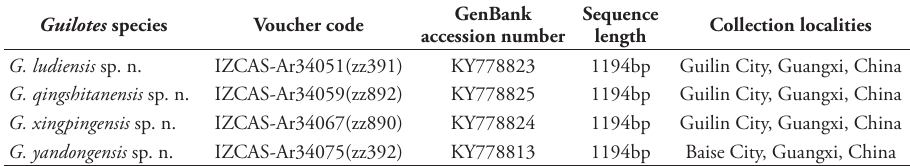
Table 1. Voucher specimen information.